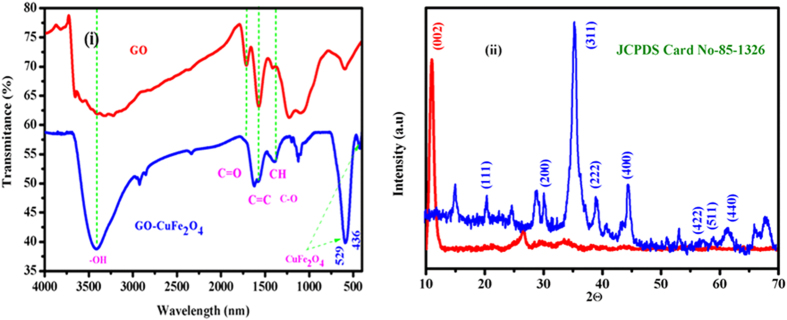
(i) FTIR spectra of GO and GO-CuFe2O4 nanocomposite and (ii) XRD powdered spectra of GO and GO-CuFe2O4 nanocomposite.